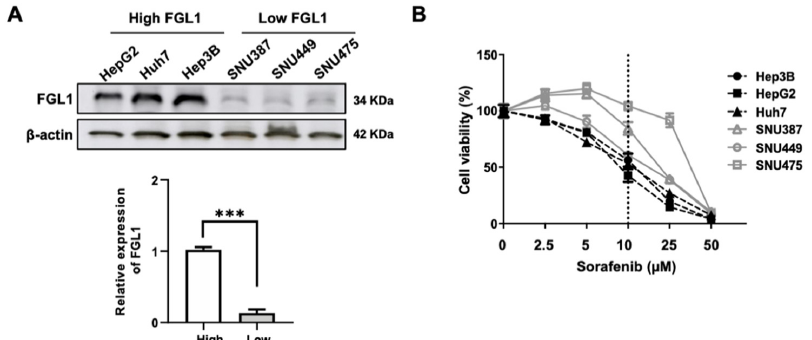
Figure 1. FGL1 expression level and viability in HepG2, Huh7, Hep3B, SNU387, SNU449, and SNU475 hepatocellular carcinoma (HCC) cell lines. ( A ) Expression of FGL1 in the six HCC cell lines, as determined through immunoblotting. Data are presented as the mean ± standard deviation (SD) (n = 3). *** p < 0.001, significantly different from HCC cells with high FGL1-expressing. ( B ) Cell viability in the six HCC cell lines after sorafenib treatment. Data are presented as the mean ± standard deviation (n = 6).